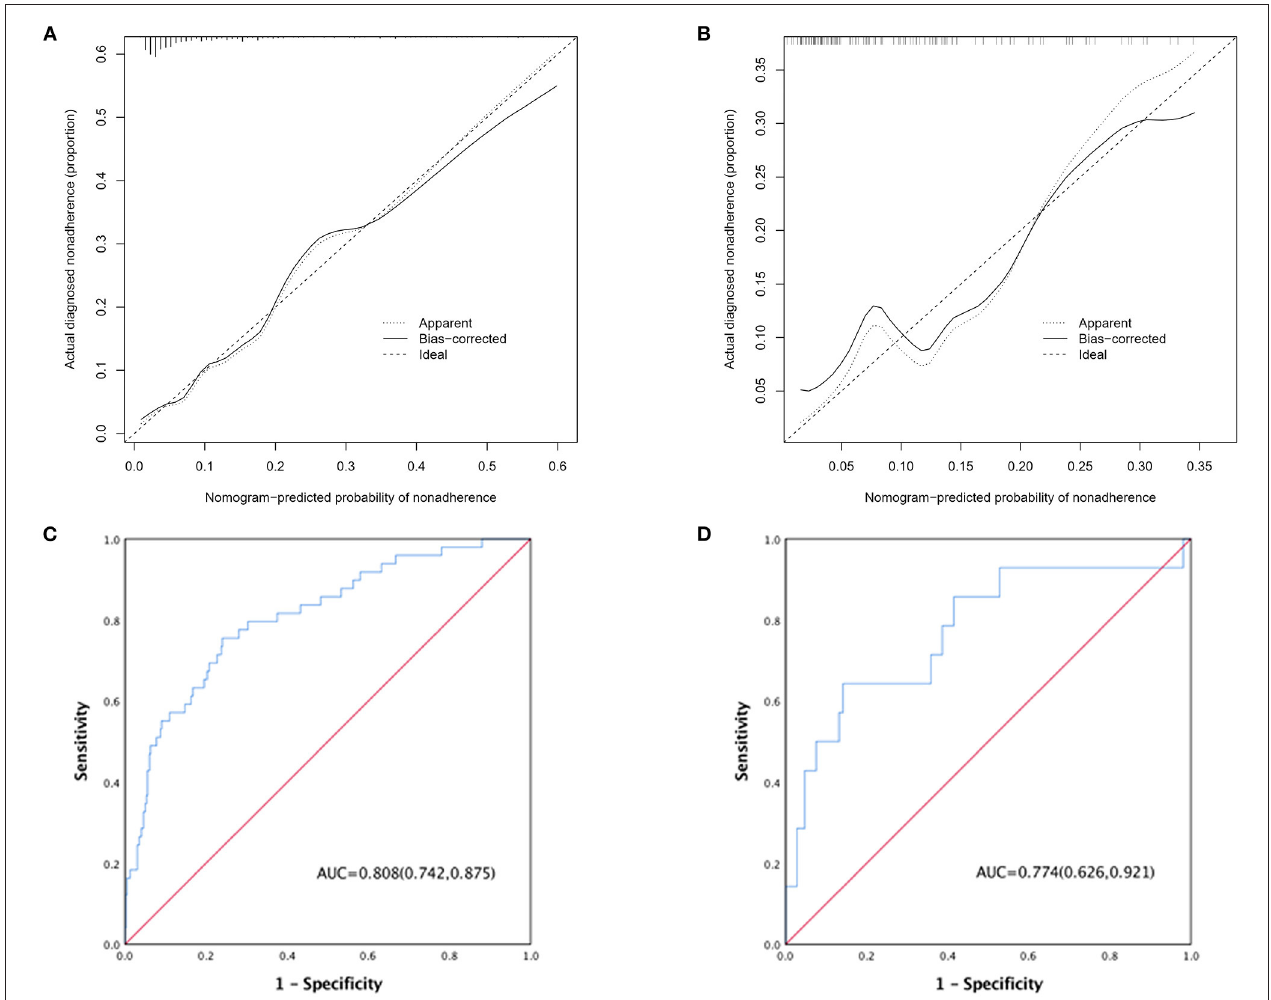
FIGURE 2 | (A) Calibration curve of the AAD nomogram in the derivation cohort, which depicts the calibration of the nomogram in terms of the agreement between the predicted risk of death and observed outcomes. The 45 ◦ dotted line represents an ideal prediction, and the solid line represents the bias-corrected predictive performance of the nomogram. The closer the solid line fits to the ideal line, the better the predictive accuracy of the nomogram; (B) calibration curve in the validation cohort; (C) ROC curve of the AAD nomogram in the derivation cohort; (D) ROC curve in the validation cohort.